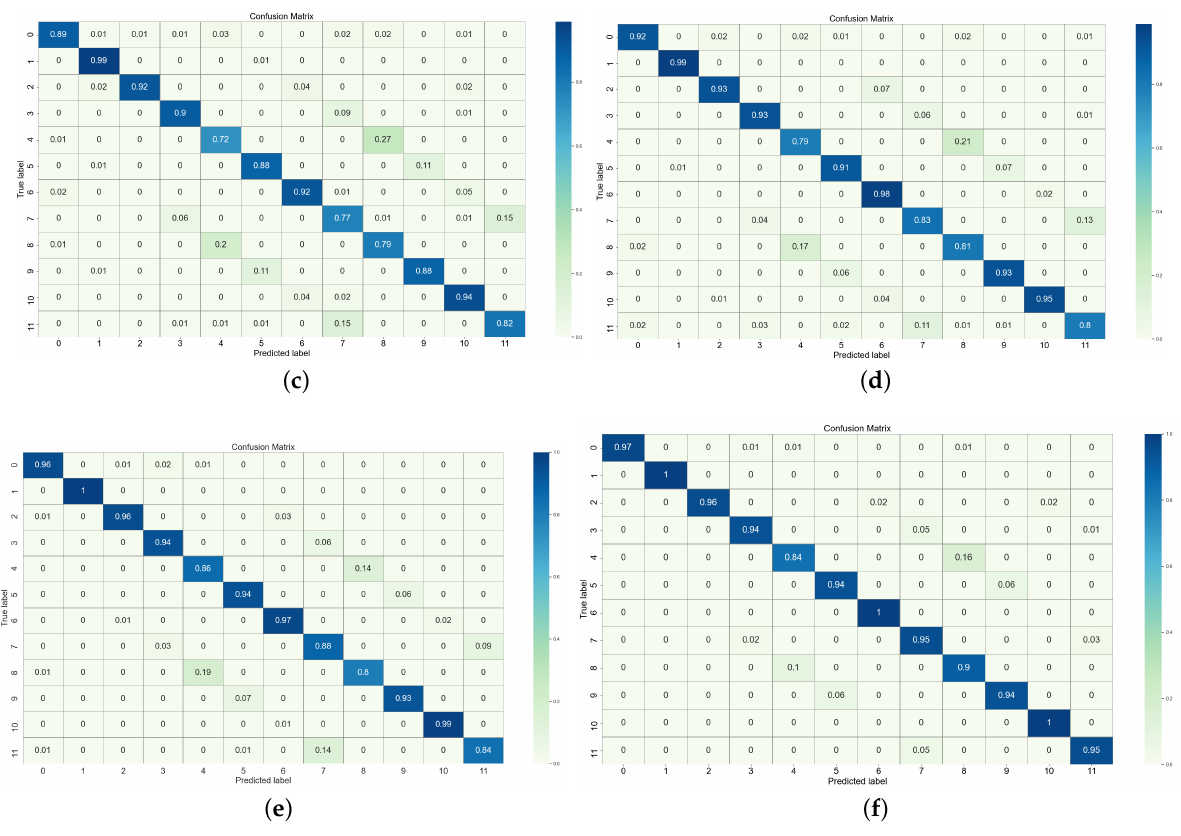
Figure 12. Confusion matrix of bearing datasets. ( a ) LeNet. ( b ) CNN. ( c ) LSTM. ( d ) BiLSTM. ( e ) MSCNN. ( f )